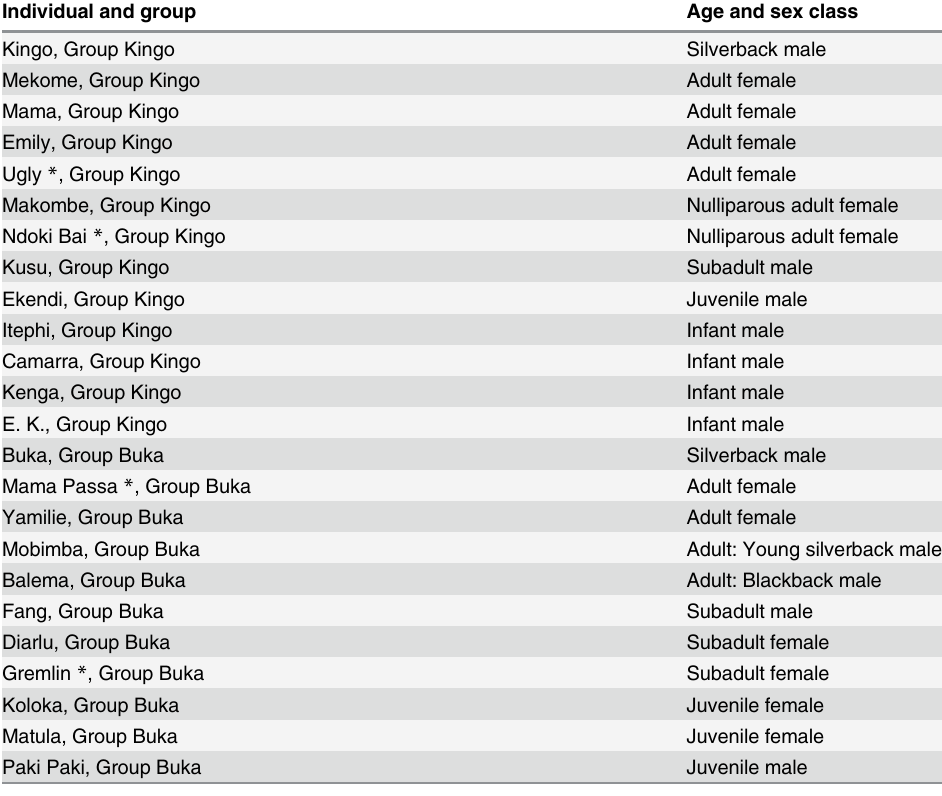
Asterisks indicate that individuals were excluded from the study due to a lesser habituation degree or because of disappearance during the fi eld